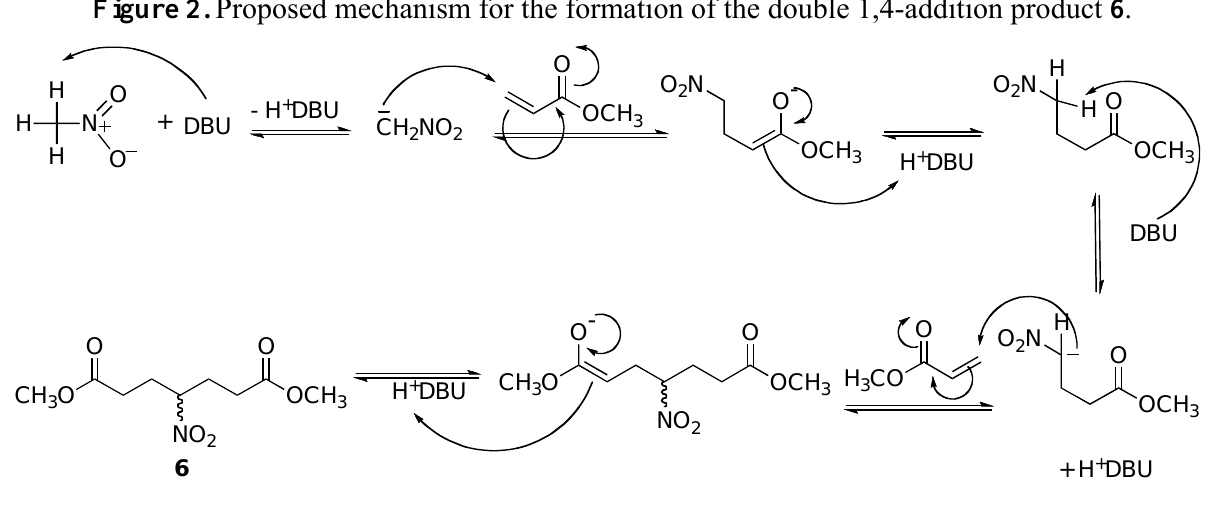
Figure 2. Proposed mechanism for the formation of the double 1,4-addition product 6 .